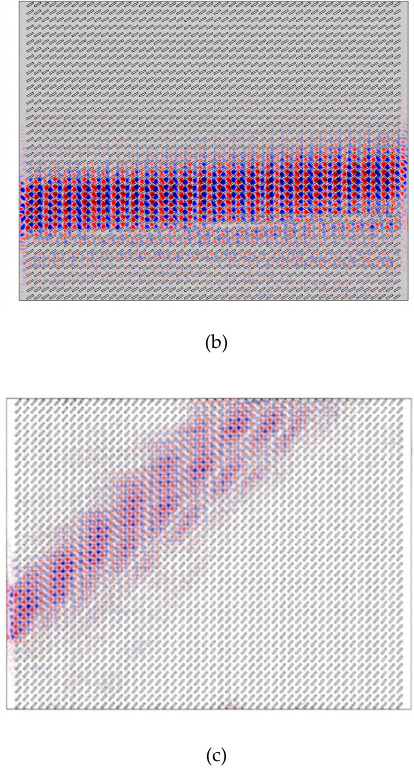
Figure 8. The displacement field simulations of the wave propagation in phononic crystals composed of star-shaped honeycomb and rectangular inclusions for ( a ) 𝜙 = 0° , ( b ) 𝜙 = 25° and ( c ) 𝜙 = 60° . The star angle of the matrix is 𝜃 = 55° and the dimensions of the rectangular inclusions are 𝑤 = 14/15𝑎 , h = a/5 .